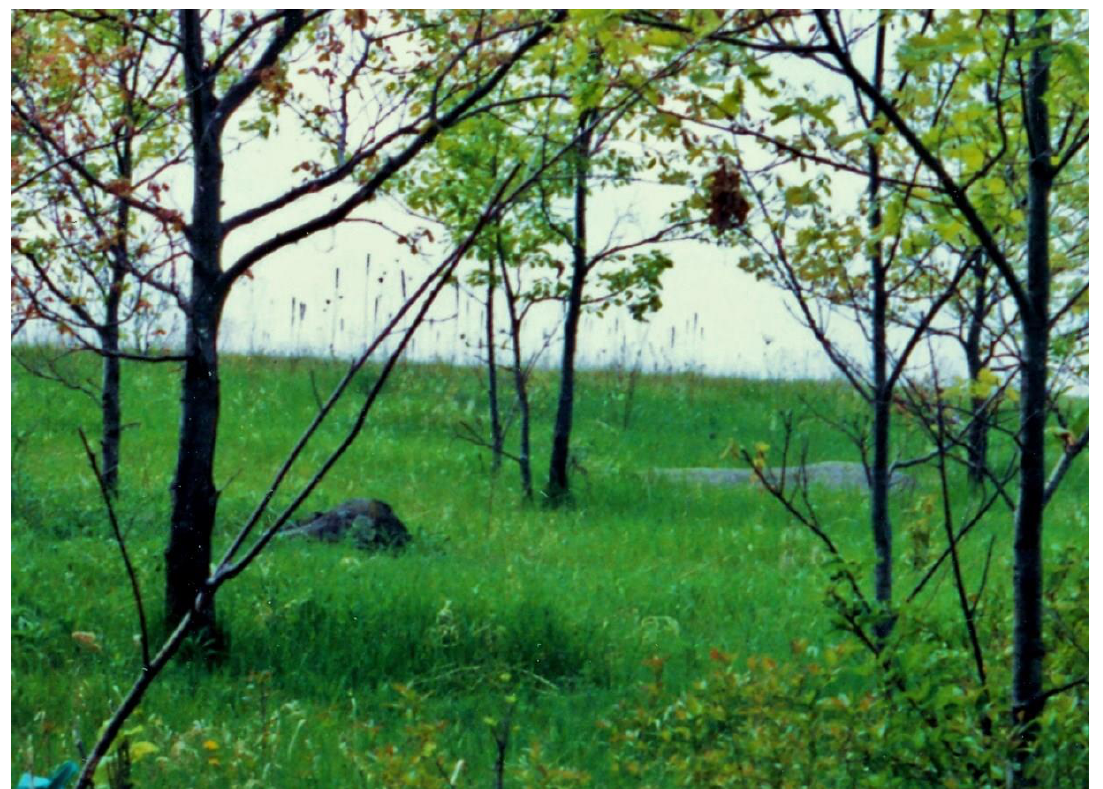
Figure 8. Photograph of the Starman petroform bison-shaped 'pelvis' rock (at left) and headstone (at right) in the tall grass (see Figures 2 and 4). View is looking approximately north.